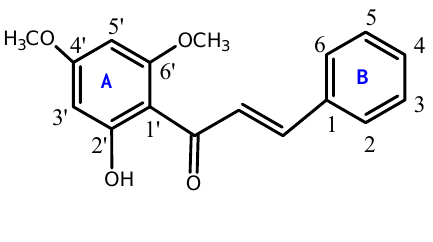
Figure 5. Chemical structure of flavokawin B